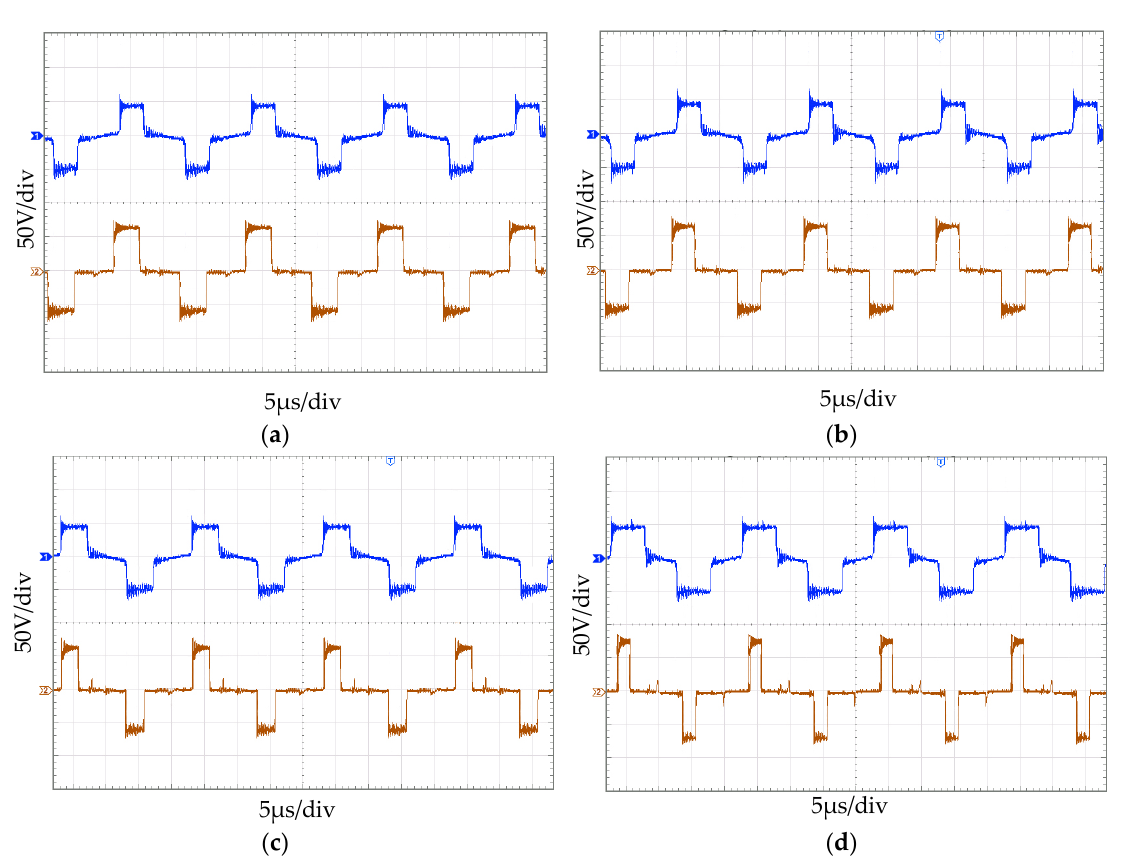
Figure 9. Waveforms of u1 and u2 under different offset distances. ( a ) s = 0 cm; ( b ) s = 5 cm; ( c ) s = 10 cm; ( d ) s = 15 cm.